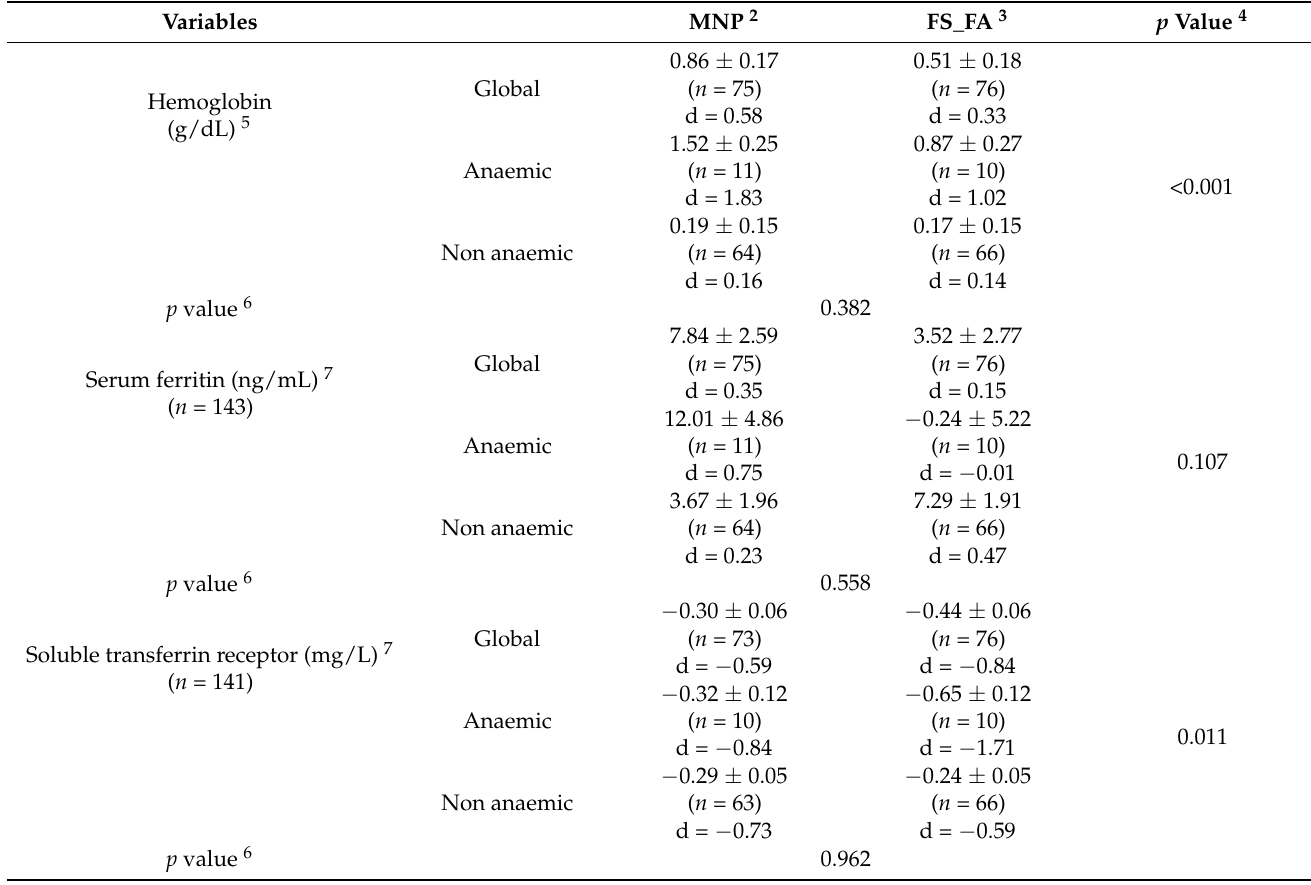
Table 4. Delta values between periods ( ∆ : after intervention—baseline) 1